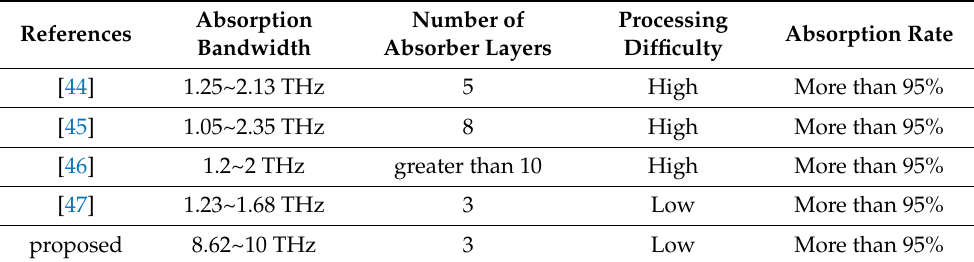
Figure 2. The absorption simulation curve of the absorber at normal incidence in: ( a ) TE, ( b ) TM. Table 1. Some broadband absorbers in the terahertz band in recent years.